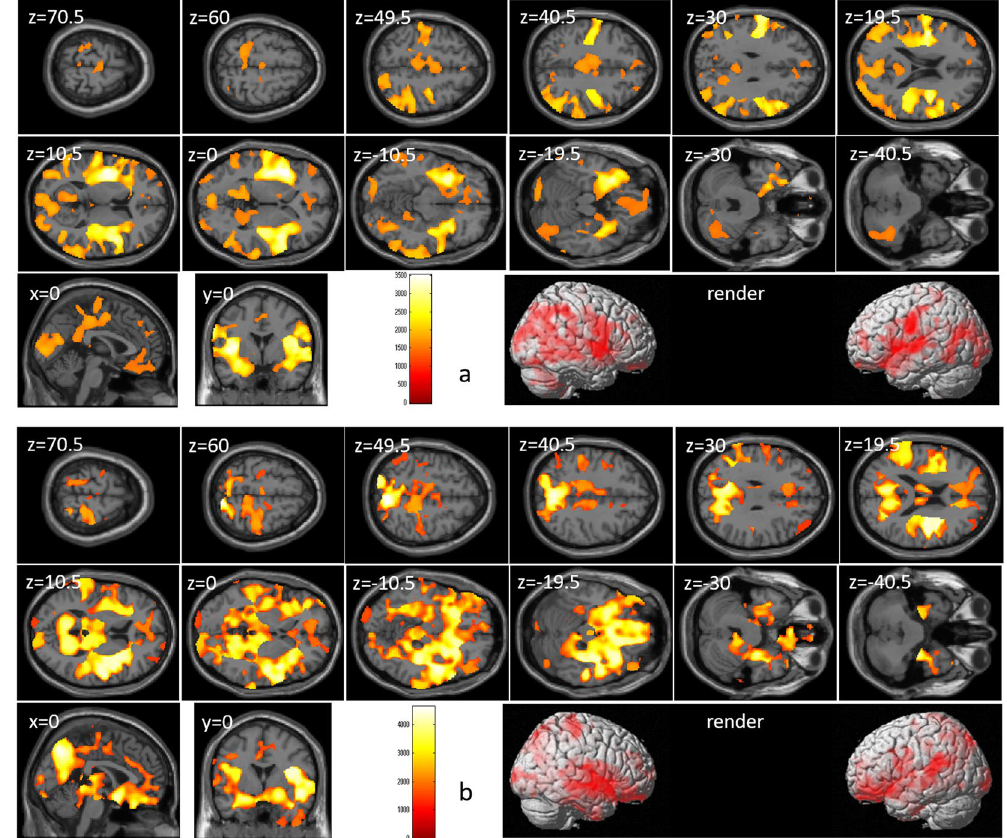
Figure 8. Relationships between rGMV and the “g-independent” digit span score as well as the general intelligence factor g. Figures represent areas of significant positive correlation of rGMV with the ( a ) “g-independent” digit span score and ( b ) general intelligence factor calculated from the four CCA measures in this study (excluding Stroop interference and digit span) by multiple regression analysis including age, sex, and these two CCA measures as independent variables. The results shown were obtained using a threshold of TFCE, P < 0.05 corrected (FWE) based on 5000 permutations. In section images, the color bar represents TFCE values. Significant positive correlations were found for the “g-independent” digit span score and general intelligence factor in most anatomical areas of the whole brain (with the general exception of the dorsal part of the brain, where significant voxels were